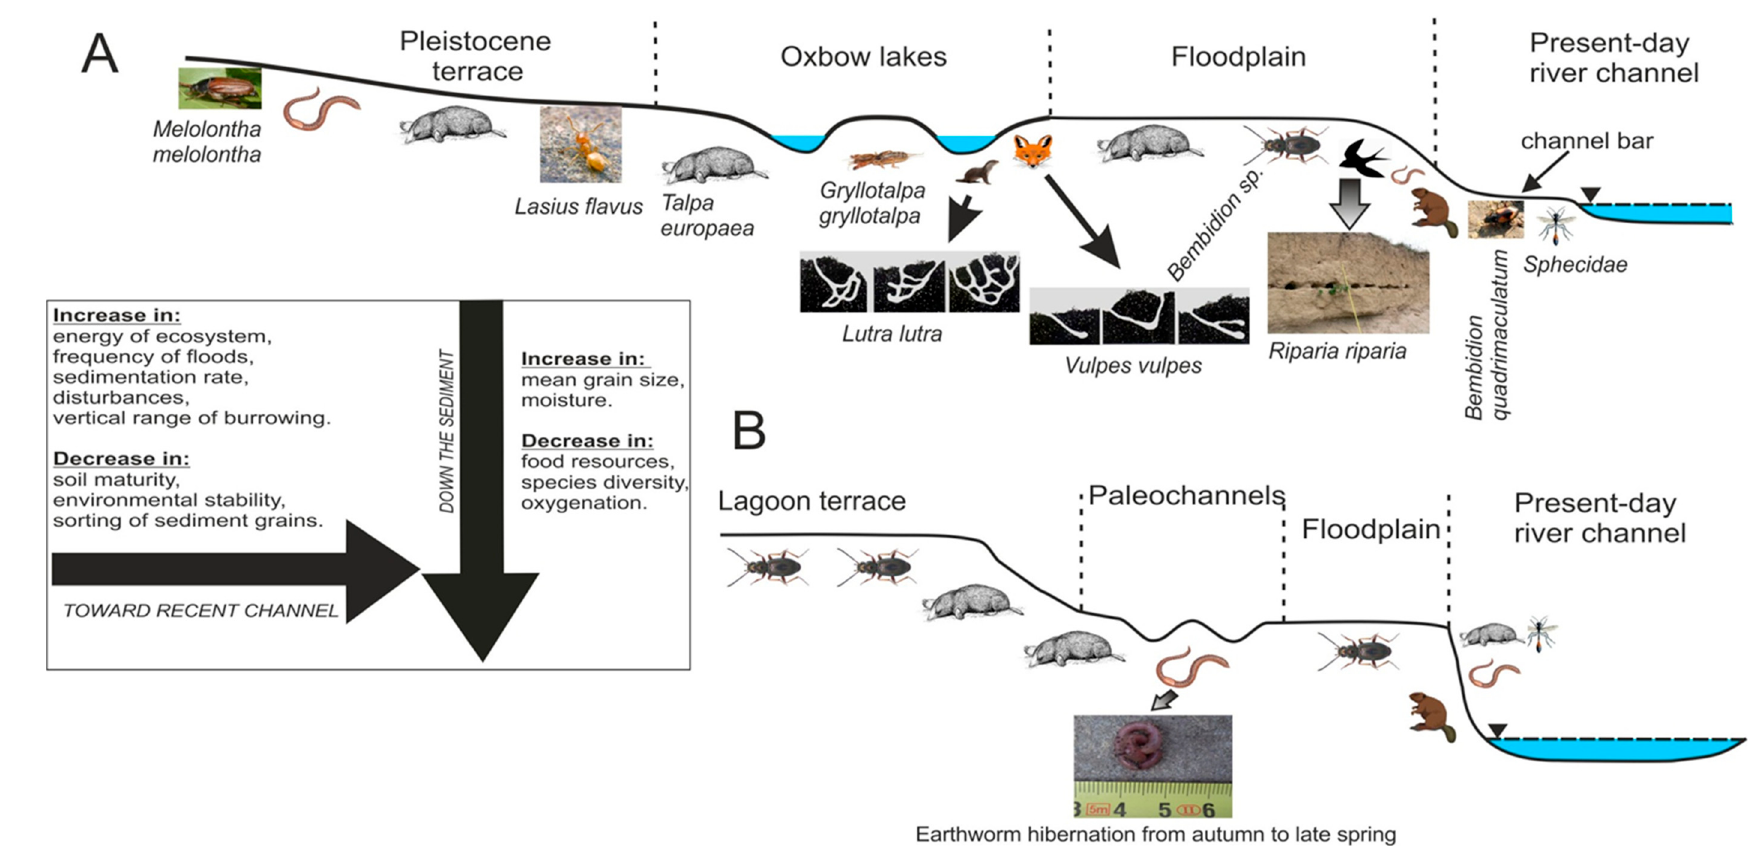
Figure 5. Distribution of the studied burrows with the most common geomorphic units of their occurrence and the main factors controlling burrowing activity within the studied reach of the Dunajec River ( A ) and the Wielki Rogo ź nik Stream ( B ).